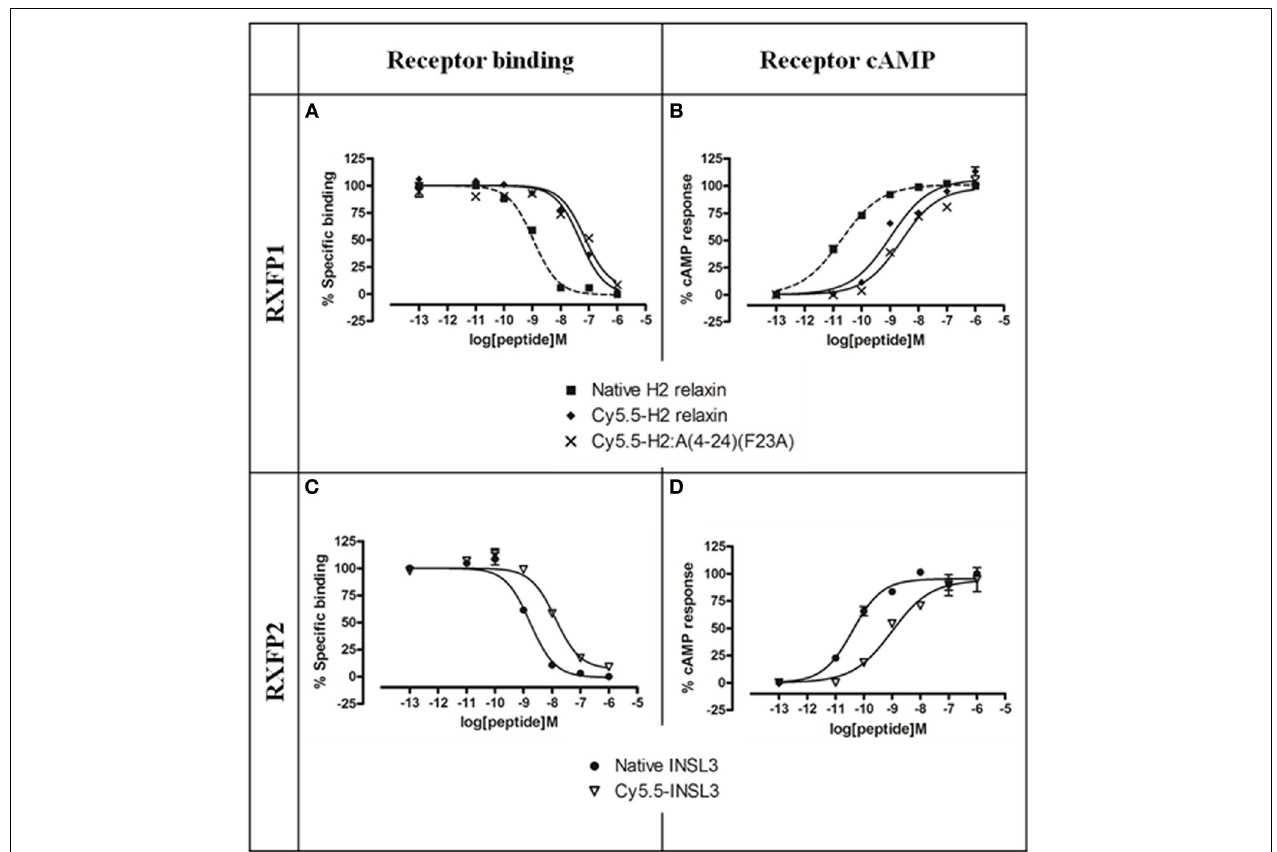
FIGURE 3 | Activity of Cy5.5 insulin/relaxin family peptide analogs at RXFP1 or RXFP2. (A) Competition binding of native relaxin and Cy5.5-H2 relaxin analogs in the presence of the competitive ligand Eu 3 + -labeled H2 relaxin tested in HEK-293T cells stably expressing RXFP1. (B) Effect of native H2 relaxin and Cy5.5-H2 relaxin analogs on cAMP-related activity in HEK-293T cells expressing RXFP1 using a pCRE-galactosidase reporter gene system. (C) Competition binding of native INSL3 and Cy5.5-INSL3 in